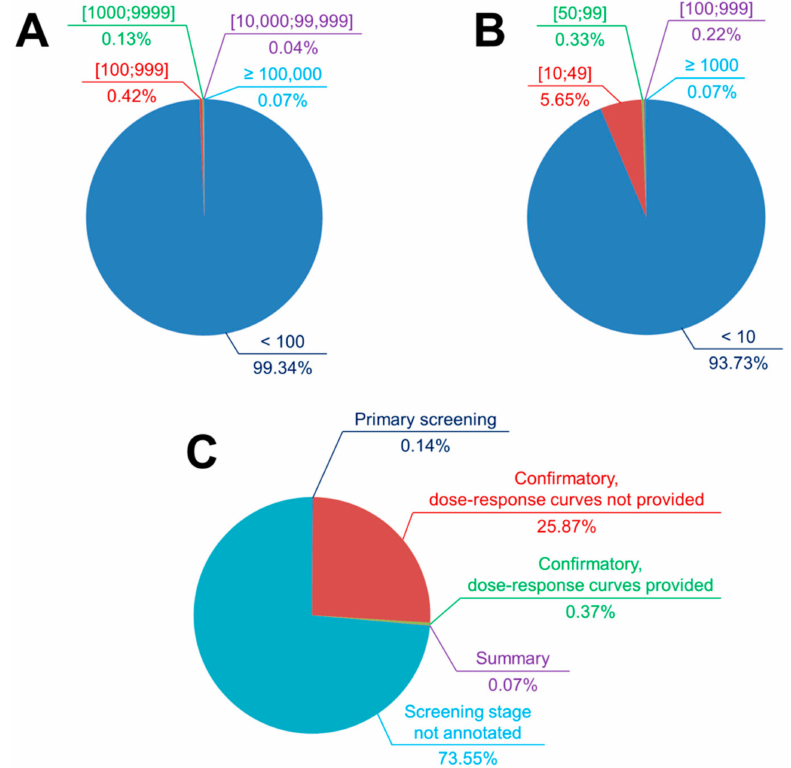
Figure 1. Partition of small-molecule PubChem bioactivity assays according to the number of tested substances ( A ), the number of active substances ( B ), and the screening stage ( C ). It is observed that most assays are small-scale screening projects in which fewer than 100 substances were tested and no more than nine actives were identified. All statistics were updated as of 30 April 2020.